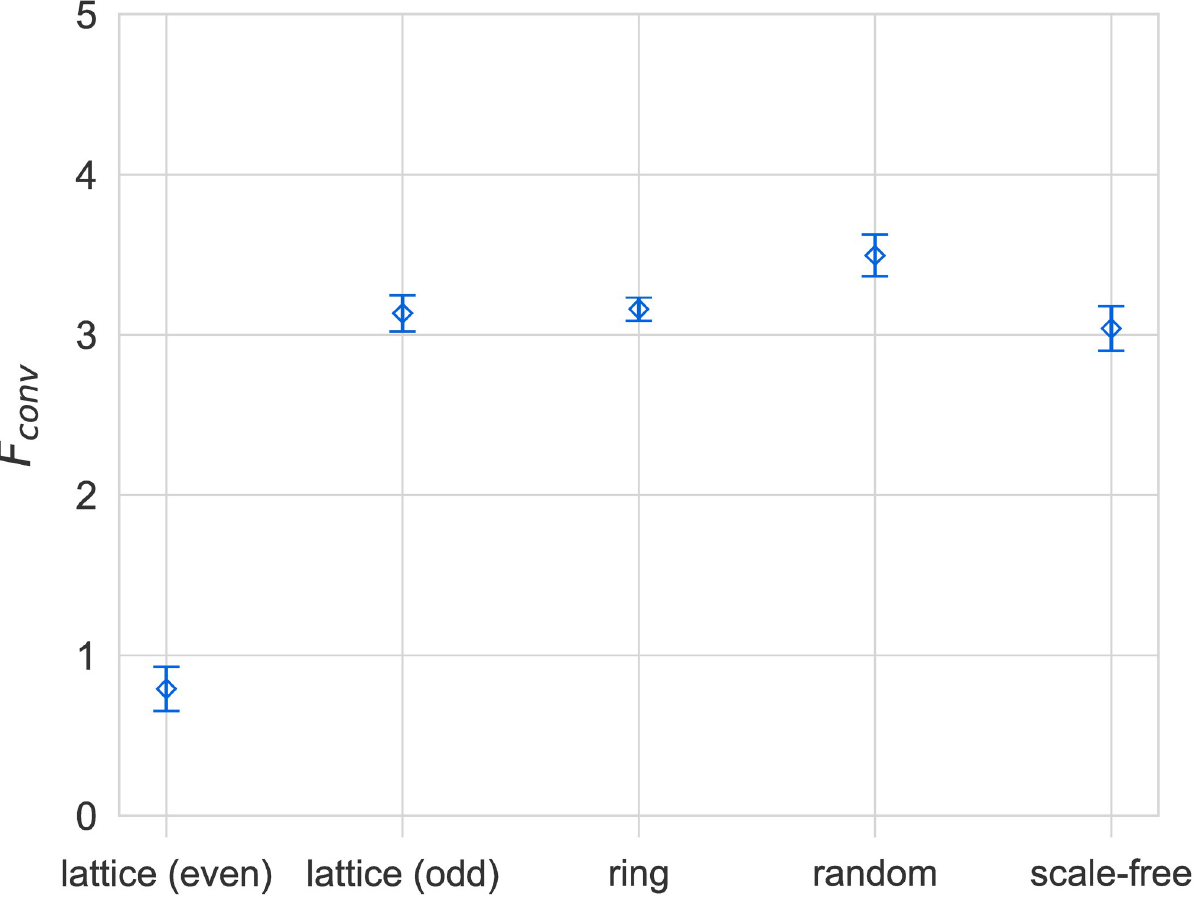
Fig 5. Differences in final payoffs of languages F conv after convergence on different network topologies. There are no significant differences in final payoffs for different network topologies, except for even-sized lattices. Results are for N = 500 and bars indicate standard errors.